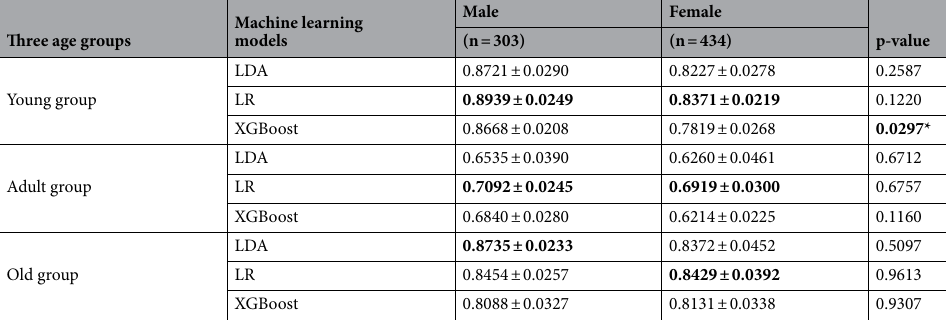
Table 3. Gender differences in the AUC values of LDA, LR, and XGBoost. The results of the gender comparison were obtained using t-tests. Statistical significance was set at P < 0.05. LDA linear discriminant analysis, LR logistic regression, XGBoost extreme gradient boosting. The model with the highest AUC value shown in bold in each group.